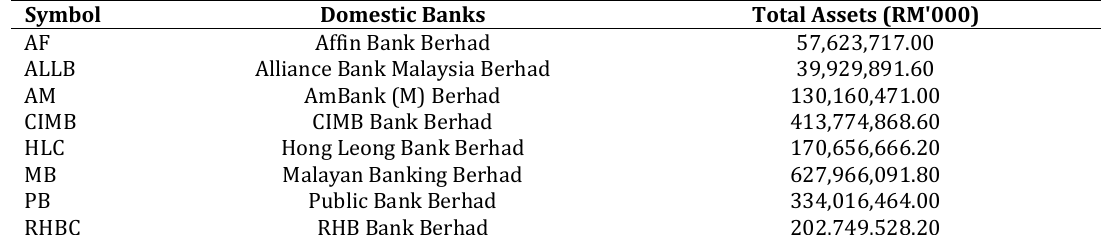
Table 1: Total Assets of respective domestic bank in